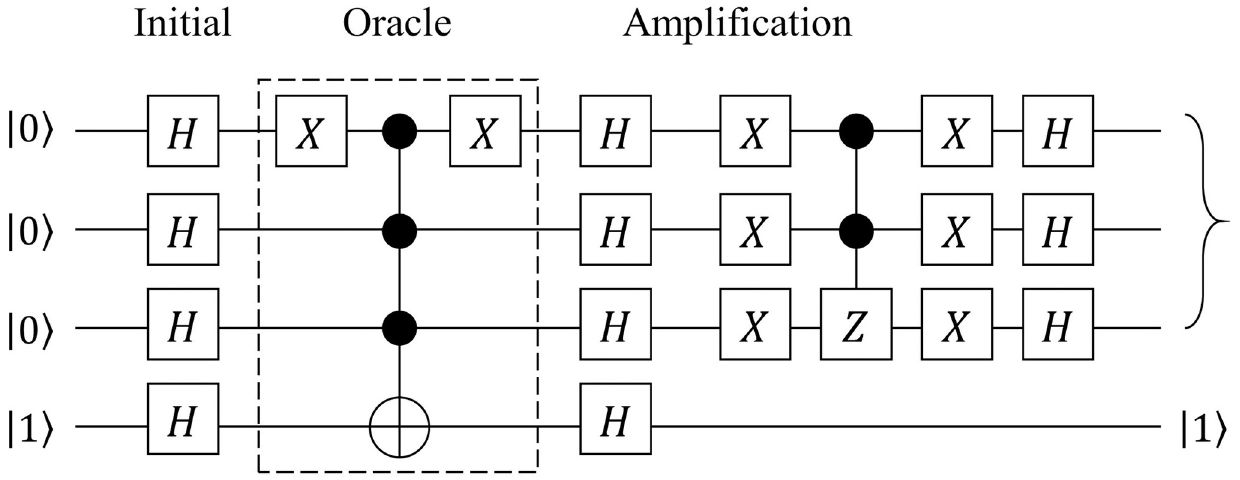
Fig 1. Quantum circuit of Grover’s algorithm. A quantum circuit implementing Grover’s algorithm with four qubits [50].